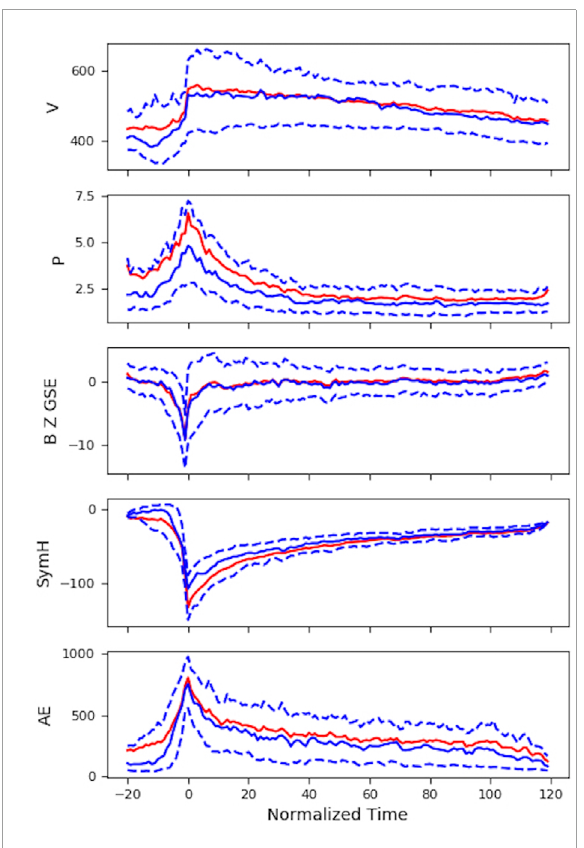
FIGURE 2 Result of the one-dimensional, time-normalised superposed epoch analysis for OMNIWeb parameters solar wind speed (V), dynamic pressure (P), southward interplanetary magnetic field (B z ), Sym-H and the Auroral Electrojet (AE) index. The statistics plotted are the mean (red), median (blue solid), upper and lower quartiles (blue dashed) for data within 168 geomagnetic storms from 1992–2004.